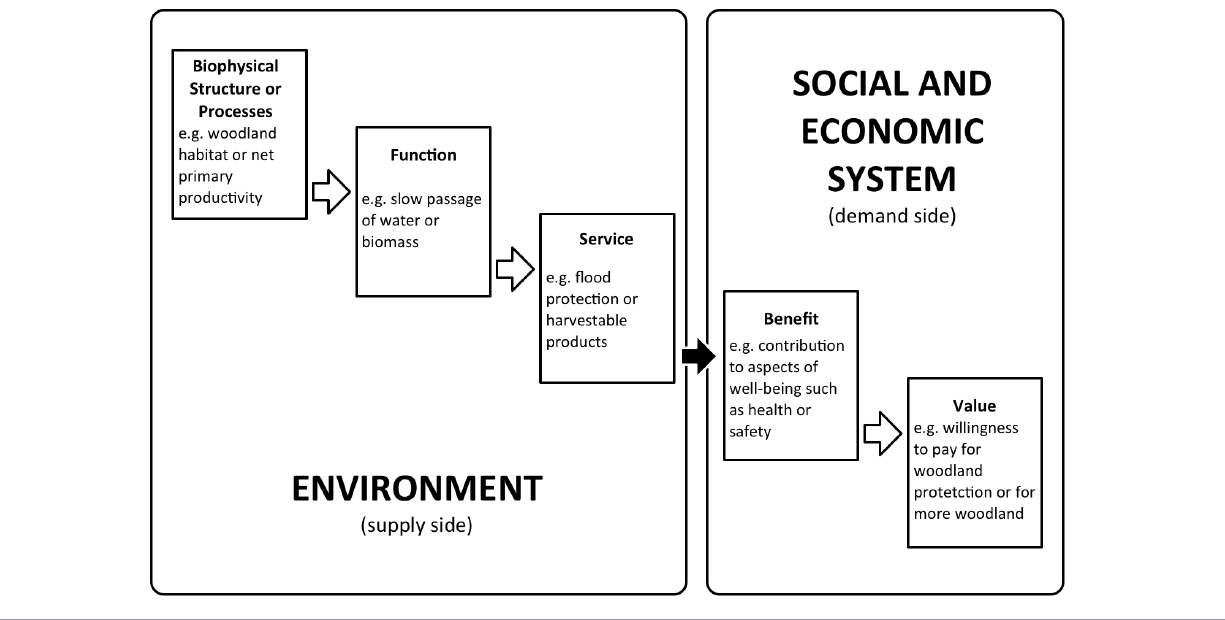
Fig. 1. The ecosystem services cascade. Adapted from Haines-Young and Potschin